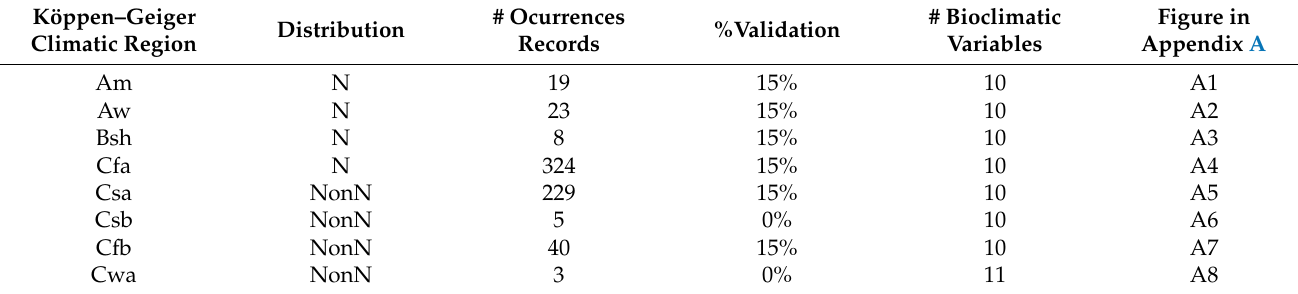
Table 2. Number of records of presence of O. drummondii for the different climatic regions (# Occurrence records); percentage of random test (% Validation), and number of bioclimatic variables used (# Bioclimatic variables) for the construction of the models. N = native distribution, NonN = non-native distribution. Köppen–Geiger climatic native regions: Tropical monsoon climate (Am), Tropical savanna climate with dry-winter characteristics (Aw) hot semi-arid climate (Bsh), and Humid subtropical climate (Cfa). Köppen–Geiger climatic non-native regions: Mediterranean hot summer climates (Csa), Mediterranean warm/cool summer climates (Csb), Temperate oceanic climate (Cfb), Dry-winter humid subtropical climate (Cwa).